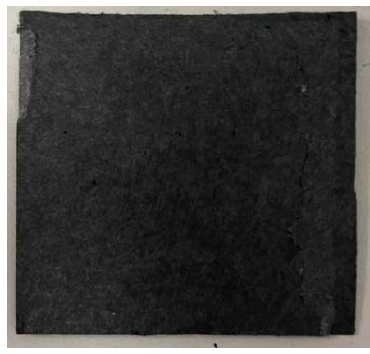
Figure 10. Carbon paper.